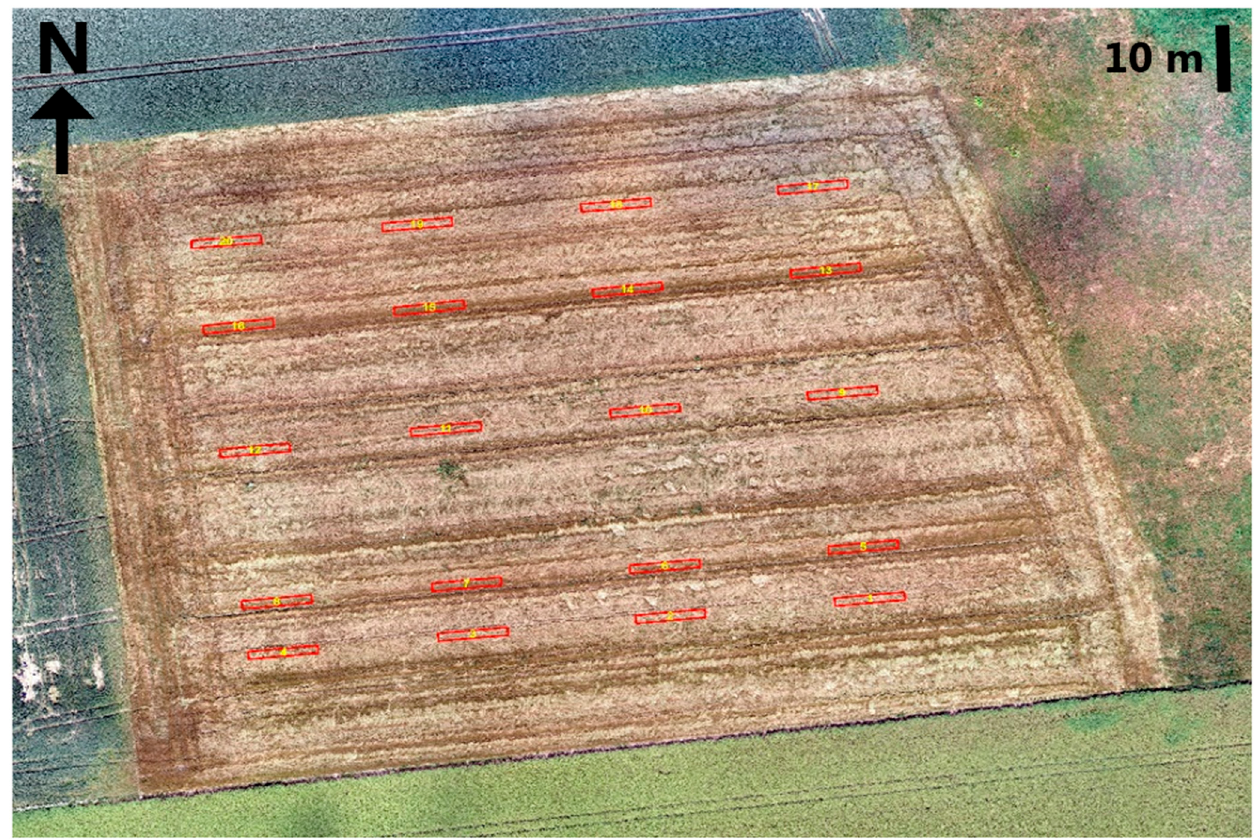
Figure 1. UAV image of the experimental plots from 2018, University of Copenhagen, Taastrup (55°40 ′ 8.16 ′ ’ N; 12°18 ′ 18.82 ′ ’ E).